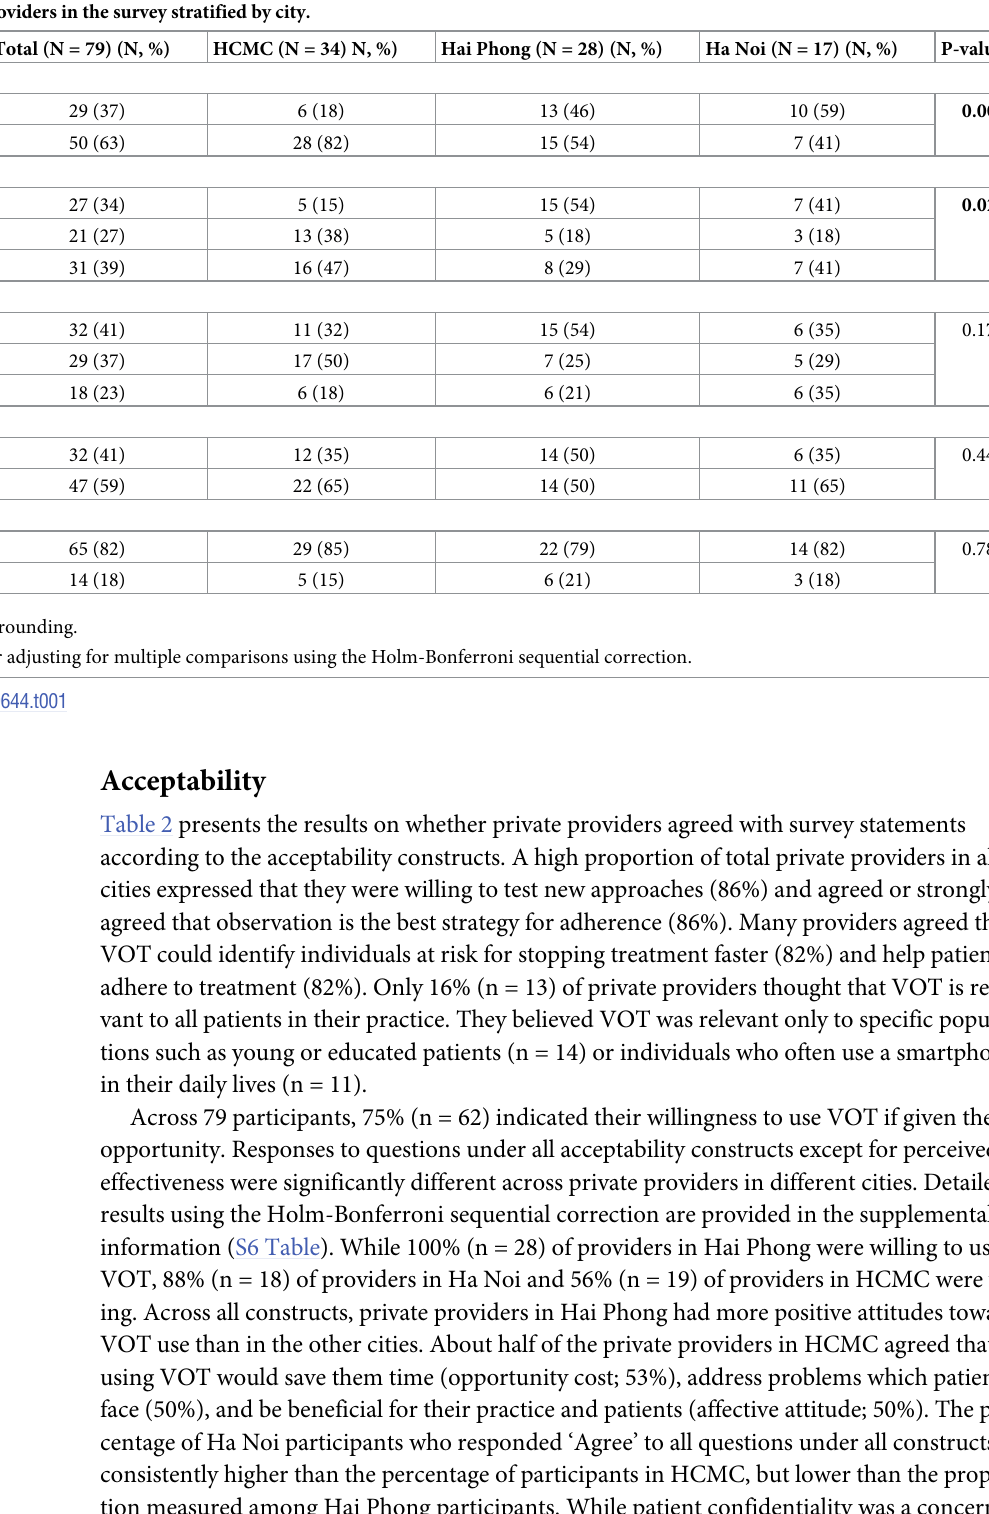
Table 1. Characteristics of private providers in the survey stratified by city.